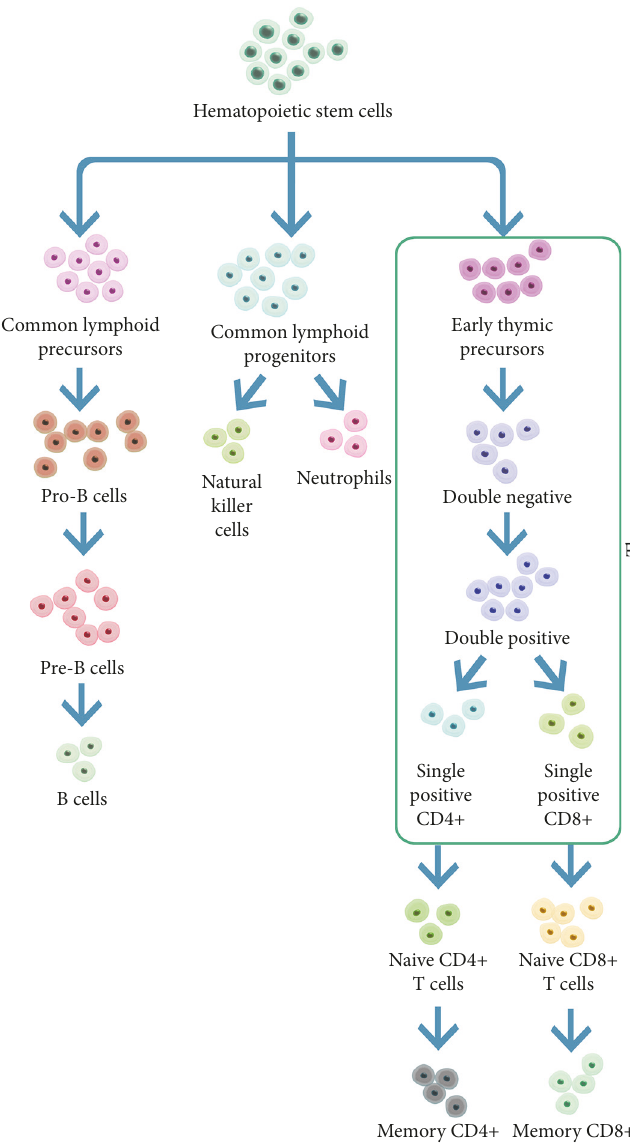
Figure 2: The development of lymphocytes. CLP cells are the earliest lymphoid progenitor cells derived from hematopoietic stem cells, giving rise to T-lineage, B-lineage, and natural killer (NK) cells. lL-7 plays a signi fi cant role at speci fi c stages in the development of these cells. (See text for